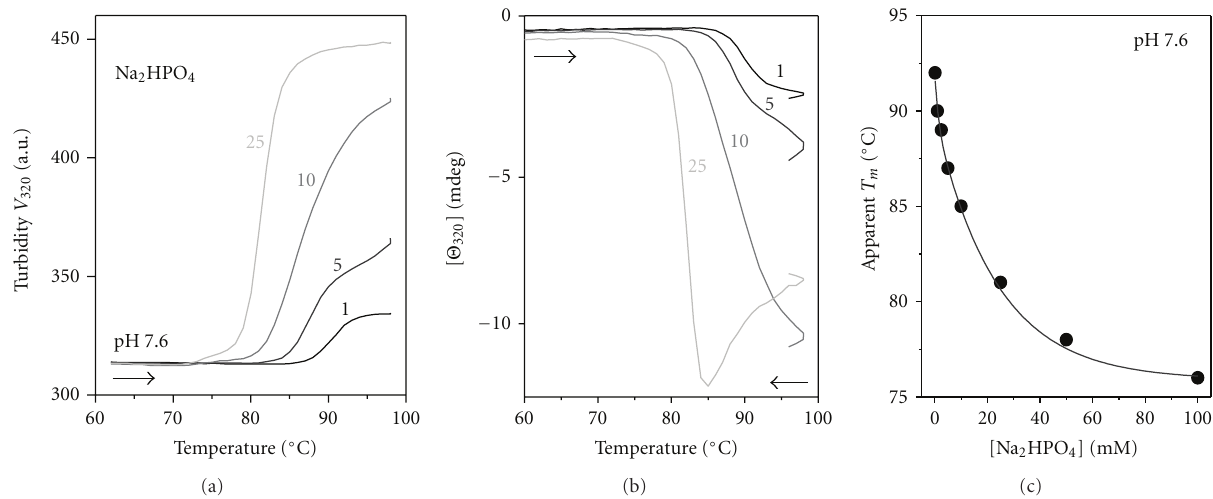
Figure 5: E ff ects of millimolar concentrations of Na phosphate on the structural stability of VLDL assessed in the melting experiments. VLDL solutions containing 1–25 mM Na phosphate (as indicated) at pH 7.6 were heated at a constant rate of 11 ◦ C/h. The turbidity (dynode voltage) and CD melting data, V 320 ( T ) and Θ 320 ( T ), were recorded simultaneously at 320nm. (a) Turbidity was used to monitor increase in the particle size due to fusion and coalescence into lipid droplets, and (b) CD was used to monitor repacking of apolar core lipids upon VLDL rupture and coalescence into lipid droplets [20, 33]. (c) The apparent melting temperature T m , which was determined from the peak position in the 1st derivative of the turbidity melting data such as those in (a), is plotted as a function of Na phosphate concentration. Data fitting with a monoexponential decay function (solid line, K = 0 . 05mM − 1 ) is characteristic of the ionic screening e ff ect [34], with K providing a measure of macromolecular sensitivity to ionic screening. A similar e ff ect of salt was observed in human HDL